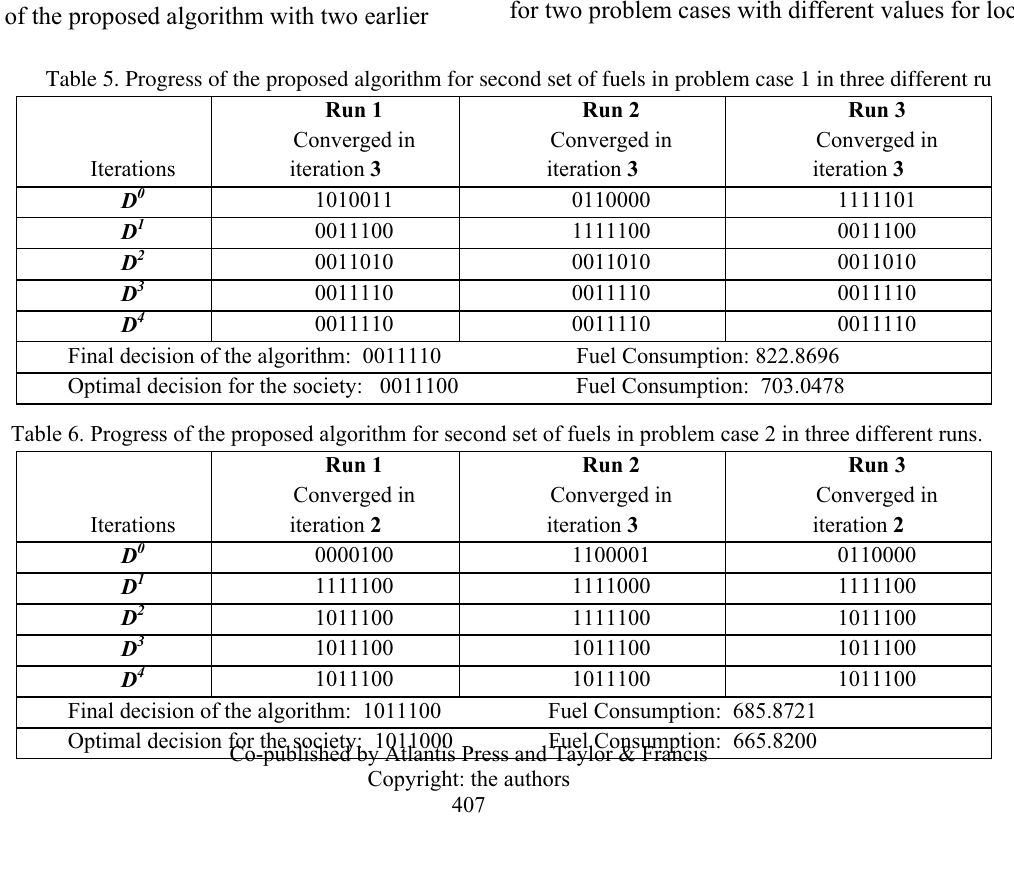
Table 5. Progress of the proposed algorithm for second set of fuels in problem case 1 in three different ru